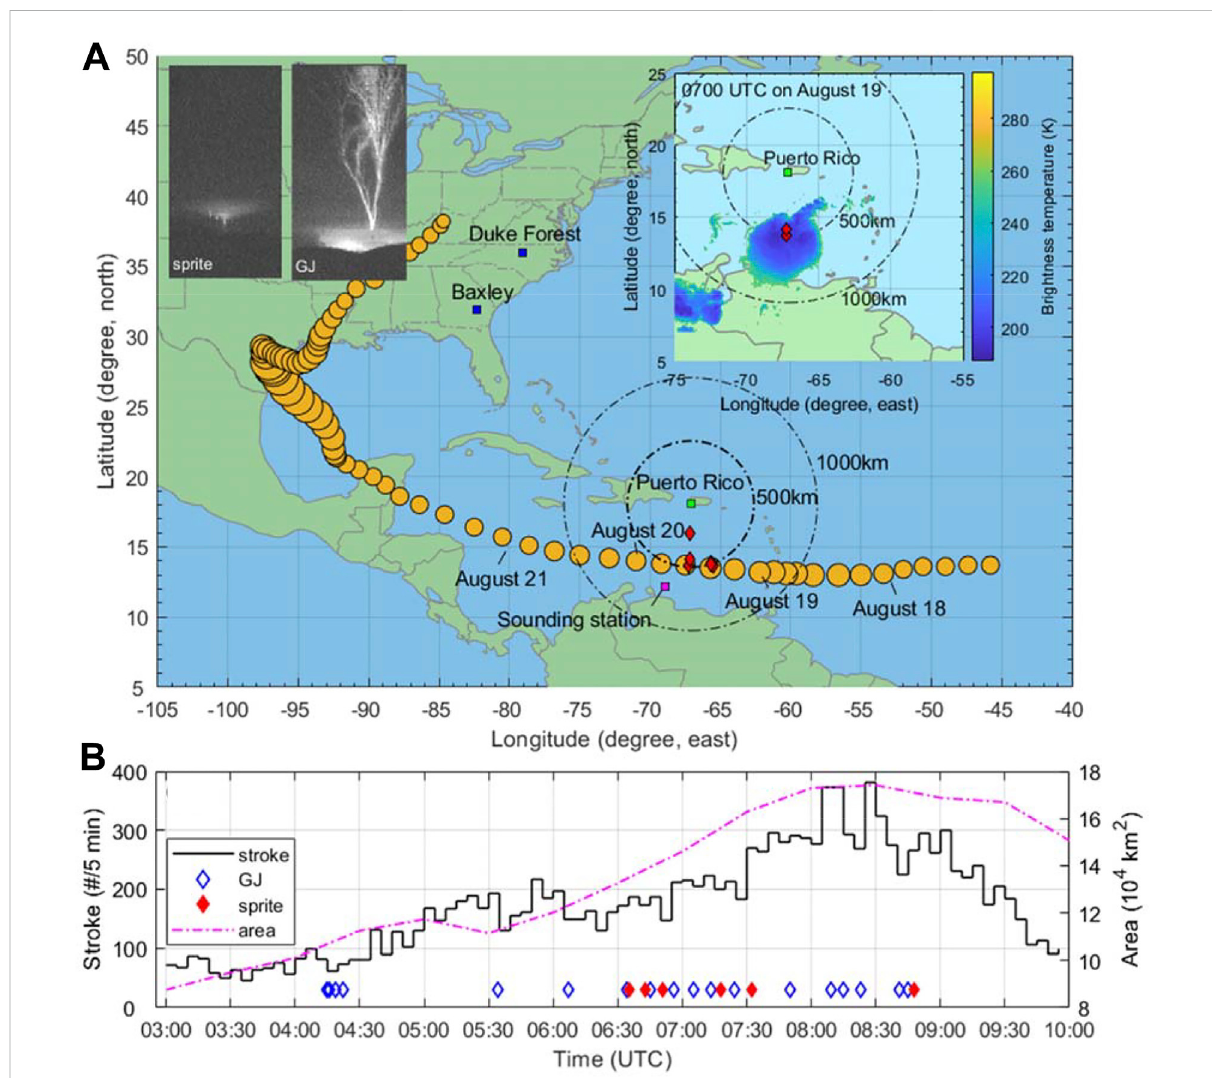
FIGURE 6 Observations of negative sprites over a tropical thunderstorm that eventually developed into Hurricane Harvey (2017). Panel (A) shows the overall track of the hurricane, and the parent lightning of TLE observations from Puerto Rico on the night of August 19. The inset images of panel (A) show the observations of one negative sprite and one gigantic jet, respectively. Panel (B) summarizes the observations in comparison with the lightning occurrence during the nighttime observation. Adapted from Wang et al.